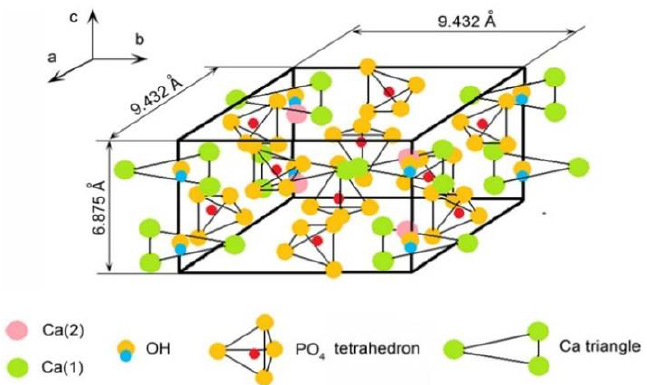
Figure 6. Diagrammatic sketch of the crystal structure of HA.